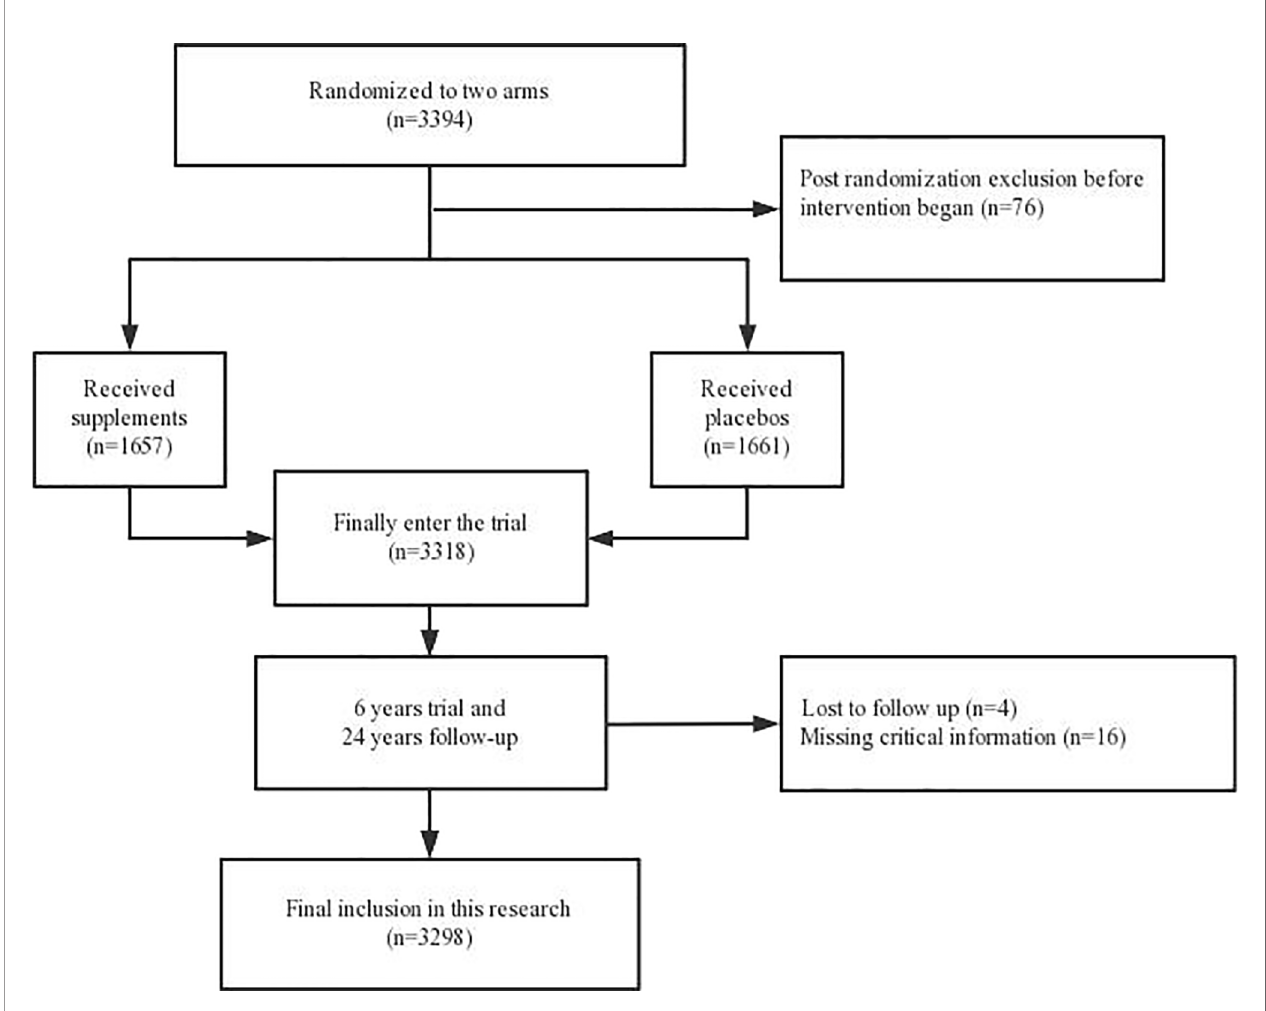
FIGURE 1 | The fl ow diagram of the Linxian Dysplasia Nutrition Intervention